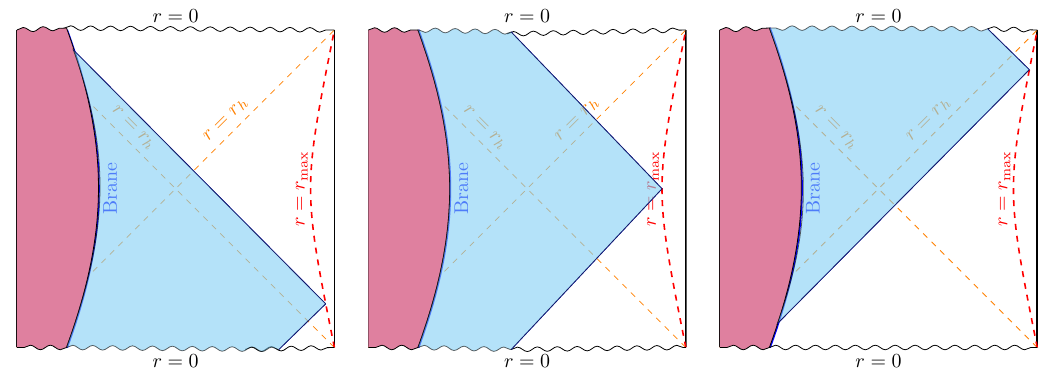
Figure 3 . WDW patch which is indicated in cyan at di(cid:11)erent times: left) early times, mid- dle) middle times and right) late times. In these diagrams, we considered the case \ T > 0 and r h < LTr max " in the (cid:12)rst regularization, however for other cases the WDW patches are similar to the above